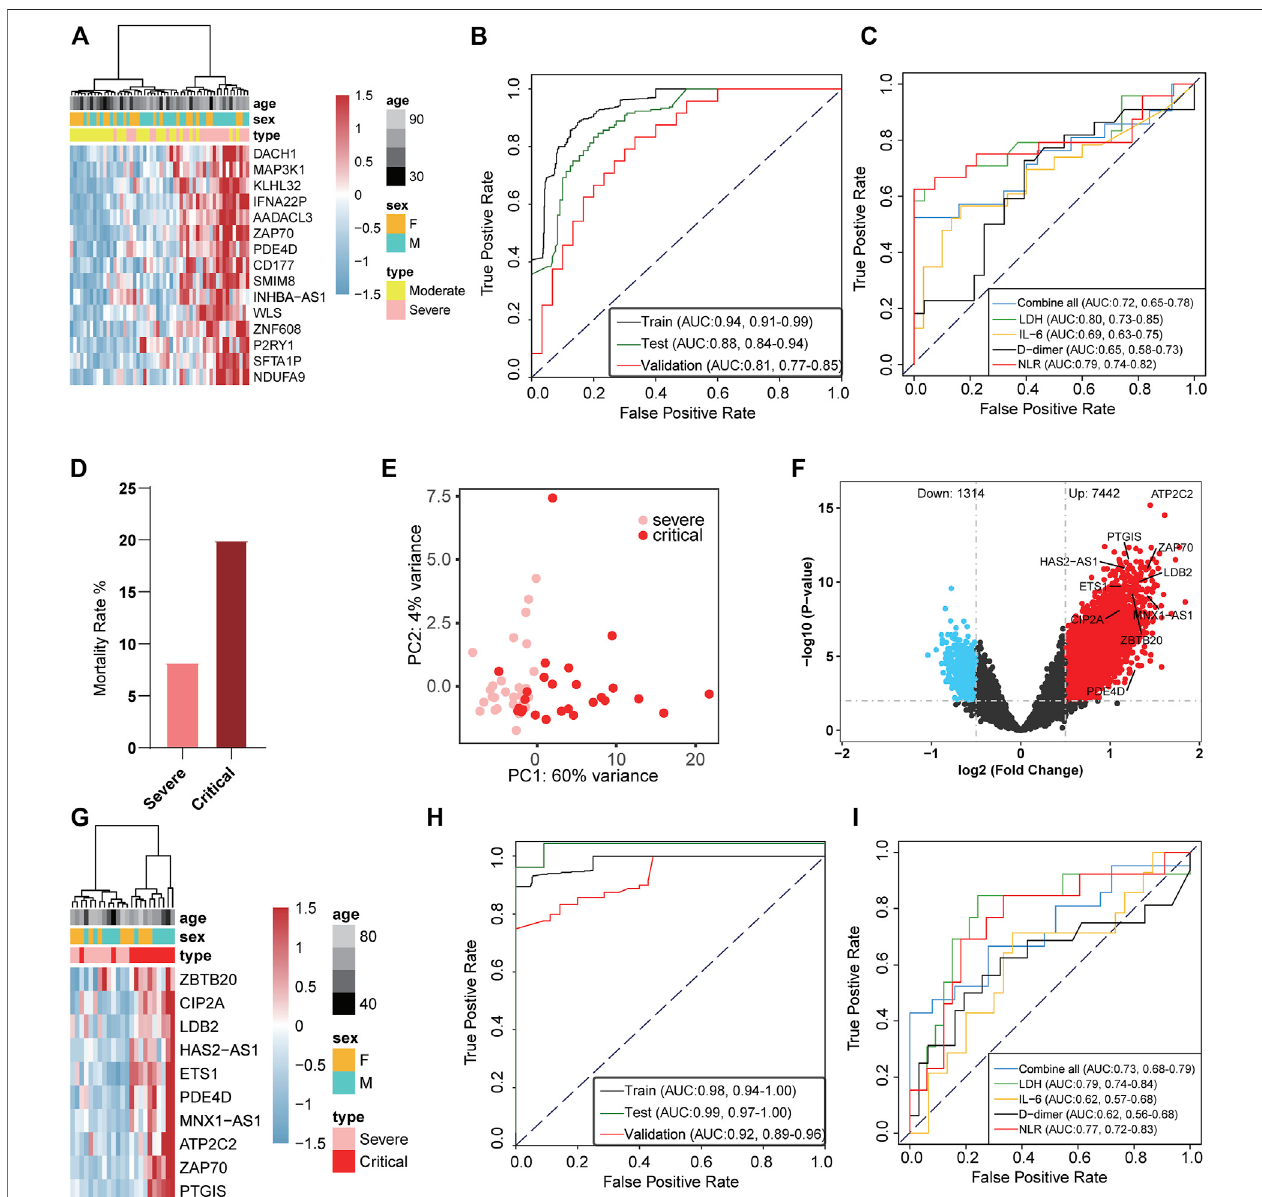
FIGURE 3 | 5-Hydroxymethylcytosine signatures in circulating cell-free DNA as a novel early warning biomarker for COVID-19 progression. (A) Heatmap of validation cohort based on 15 DhMRs-associated genes selected in the warning model. (B) Receiver operating characteristic (ROC) curve of the warning model with DhMRs in training and validation cohorts for COVID-19 progression. (C) ROC curve of the prediction model with clinical indicators in patients with COVID-19. (D) Mortality ratio in severe patients and critical patients. (E) Principal component analysis plot of normalized 5hmC reads from 27 severe patients and 26 critical patients. (F) Volcano plot (critical patients vs. severe patients). Signi fi cantly altered hMRs [abs (log2FoldChange) ≥ 0.5; p -value < 0.01] are highlighted in red (up) or blue (down) using the critical patients group as the reference ( n (cid:1) 8,756). Black dots represent the hMRs that are not differences. (G) Heatmap of DhMRs-associated genes selected for use in the warning model in the validation cohort. (H) ROC curve of the warning model with DhMRs in training and validation cohorts for COVID-19 progression. (I) ROC curve of the warning model with clinical indicators in COVID-19 progression. hMRs, 5hMc-enriched regions; DhMRs, differentially 5hMc-enriched